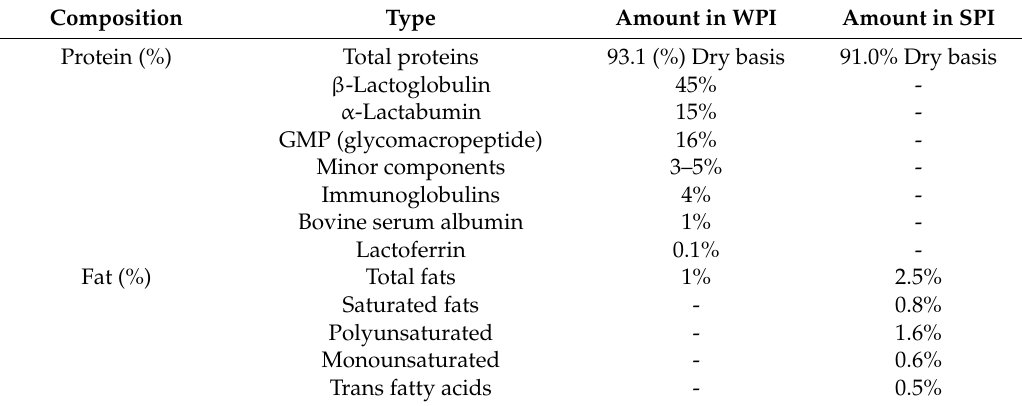
Table 2. Nutritional composition of WPI and SPI as per manufacturer’s product